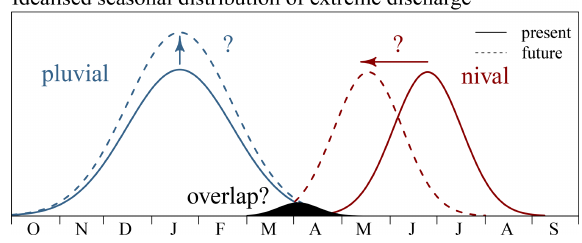
Figure 1. Idealised seasonal distribution of nival and pluvial flood frequencies and potential overlap due to climate